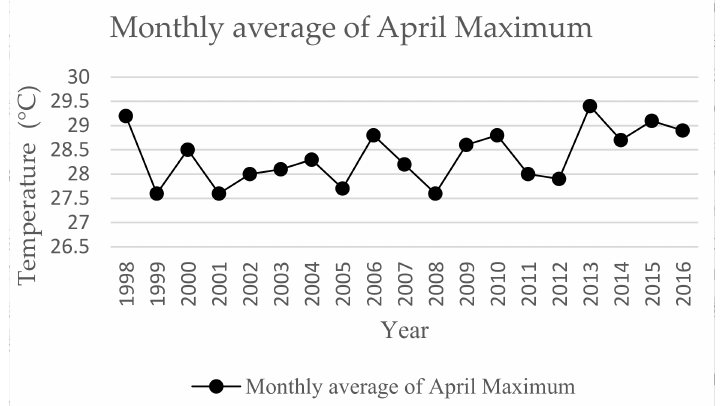
Figure 1. Mean monthly air temperature (for example March) since 1998 in Colombo is slightly on the increasing side (Data source Met Department,